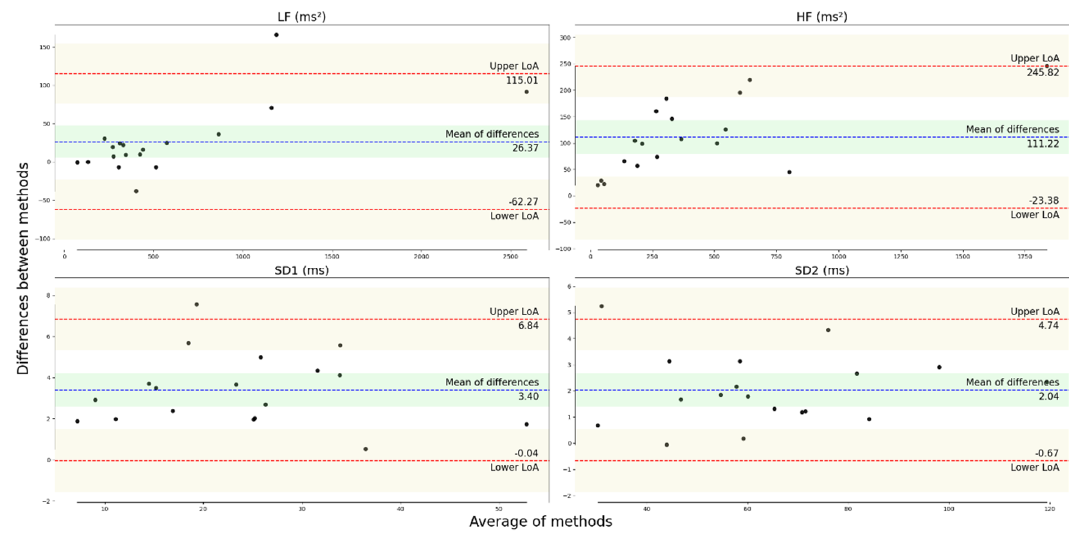
Figure A2. Bland–Altman plots for the pairs of frequency-domain and non-linear metrics obtained at rest. The blue line and the green area represent the mean of the differences between measurements and the associated confidence interval. The red lines and the associated area represent the upper and lower LoAs and the associated confidence intervals.